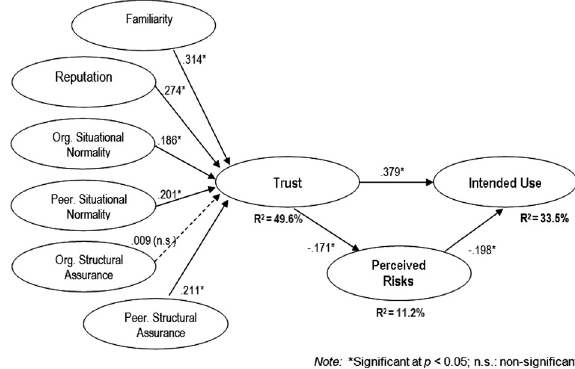
Figure 2. Structural